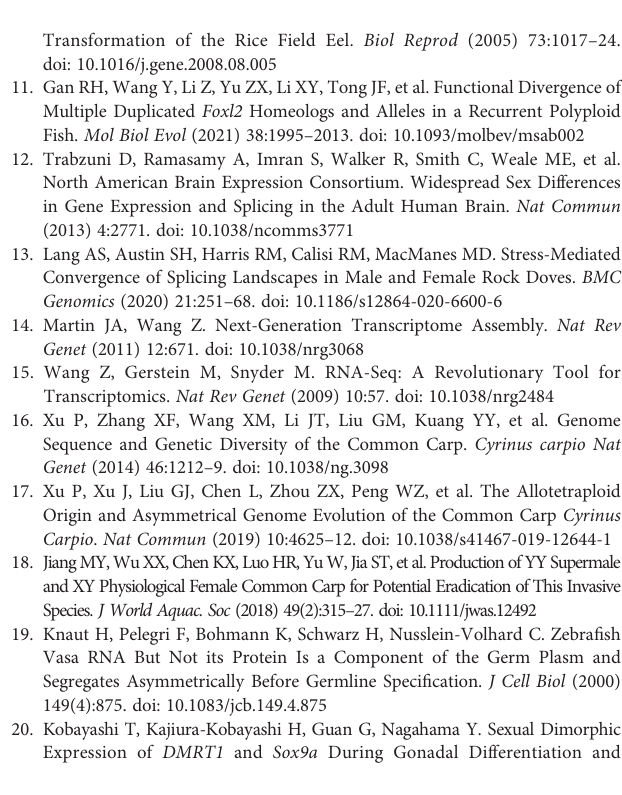
Supplementary Figure S11 | The case of the SE pattern of nrf2b gene and validation using RT-PCR in testis and brain of C. carpio . The expression of the nrf2b exons is shown with sequence coverage depth on the gene loci. Supplementary Figure S12 | The FPKM expression pro fi les of all genes during testis development. Supplementary Figure S13 | The cumulative fraction curves of the gene expression of 26 samples. Supplementary Figure S14 | Clustering of expression pro fi les in the brain. (A) Heatmap of fi ve expression clusters across gonad development. The bar plots on the right show selected GO enrichment of relevant clusters. BP: biological process; CC: cell component; MF: molecular function. (B) Statistic of gene numbers of fi ve clusters in brain; (C – G) Time-series expression pro fi le of fi ve clusters. The blue represents the average expression of the cluster, and the background lines represent all genes assigned to this cluster. The expression values were represented by FPKM/z-score. Supplementary Figure S15 | Cluster dendrogram of 23 samples following elimination of Testis_St1_3, Brain_St5_3, and Brain_St6_1. Supplementary Figure S16 | The screen of soft thresholding before weighted gene co-expression network analysis. Supplementary Figure S17 | The analysis of eigengene dendrogram of the module-trait relationship with 23 samples. Supplementary Figure S18 | The heatmap showing the module-trait relationship with 23